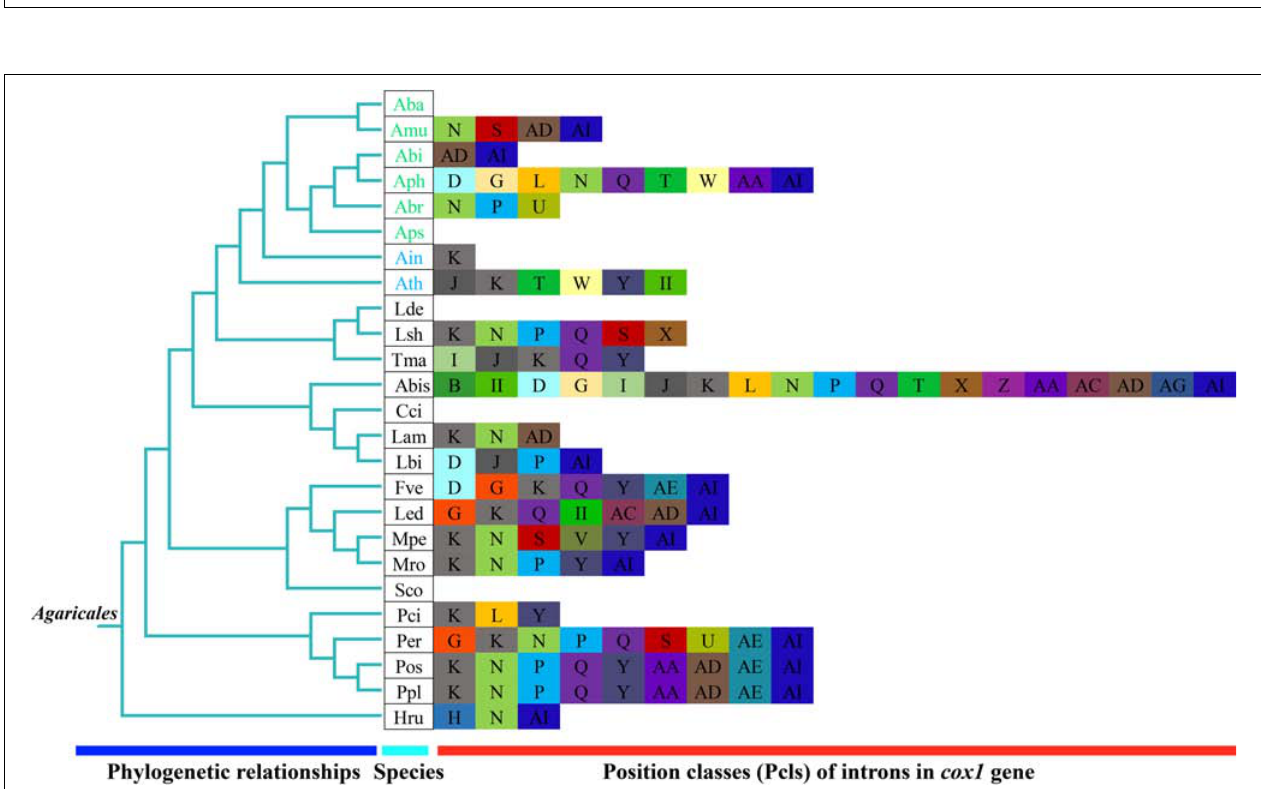
FIGURE 7 | Position class (Pcl) information of cox1 gene of the 25 Agaricales species. The same Pcl (orthologous intron) is represented by the same letter. The phylogenetic positions of 25 Agaricales species were established using the BI method and ML method based on 15 concatenated mitochondrial core proteins and two rRNA genes. The II in the figure shows the intron belongs to the group II intron. Pcls were named according to the method described by Zhang and Zhang (2019). Species IDs are given in Supplementary Table S6 .